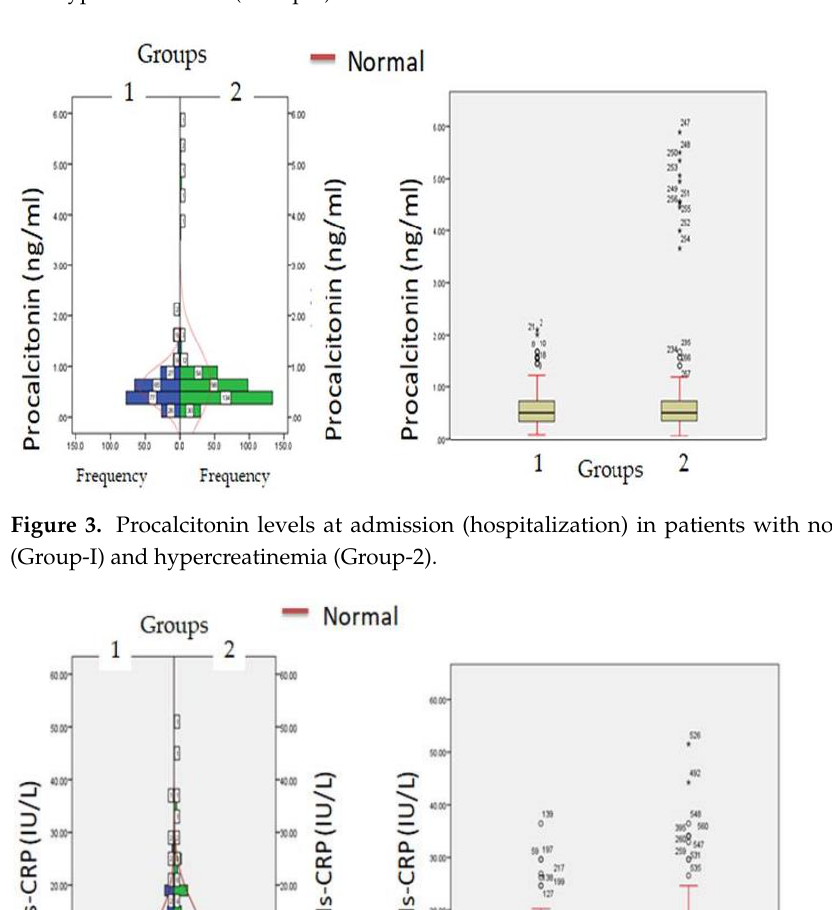
Figure 2. Ferritin levels at admission (hospitalization) in patients with normocreatinemia (Group-1) and hypercreatinemia (Group-2).